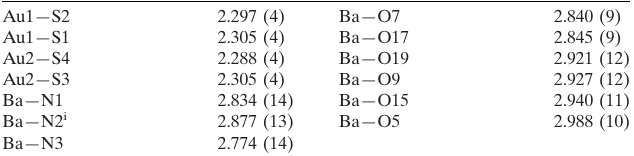
Selected bond lengths (A˚